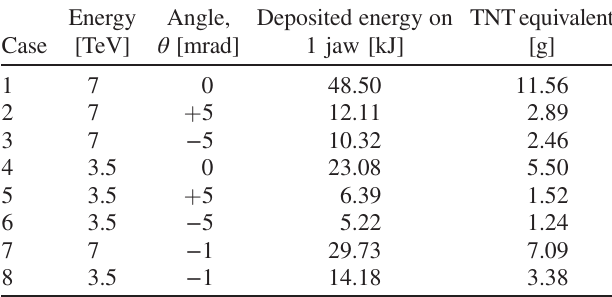
TABLE I. List of studied jaw error cases. The convention for the positive and negative values of the angle is as depicted in Fig. 6. The LHC operation started at a lower-than-design energy of 3.5 TeV in 2010, with the goal to reach the design parameters of 7 TeV per beam in the